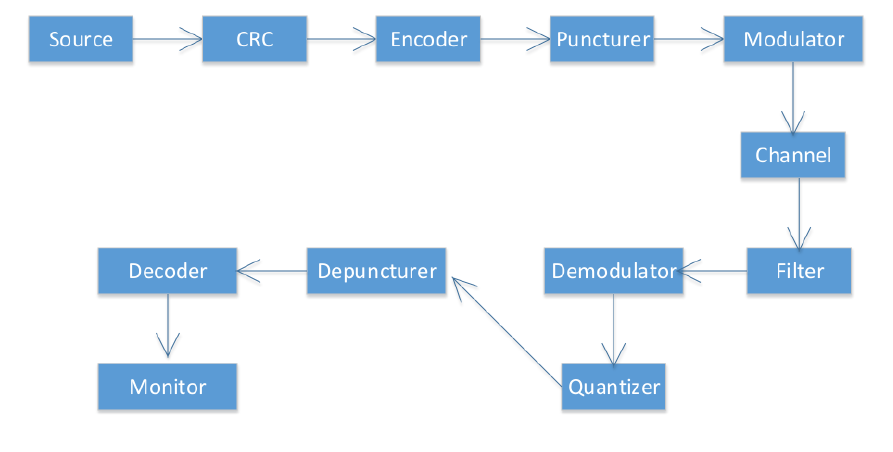
Figure 4. Standard BER/FER